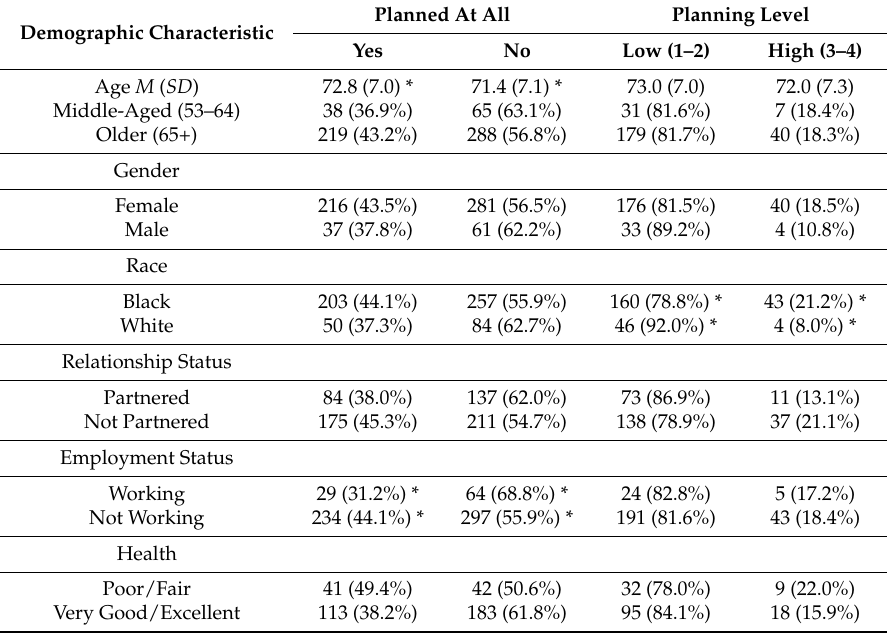
Table 6. Demographic Comparisons of Planning for Nondriving